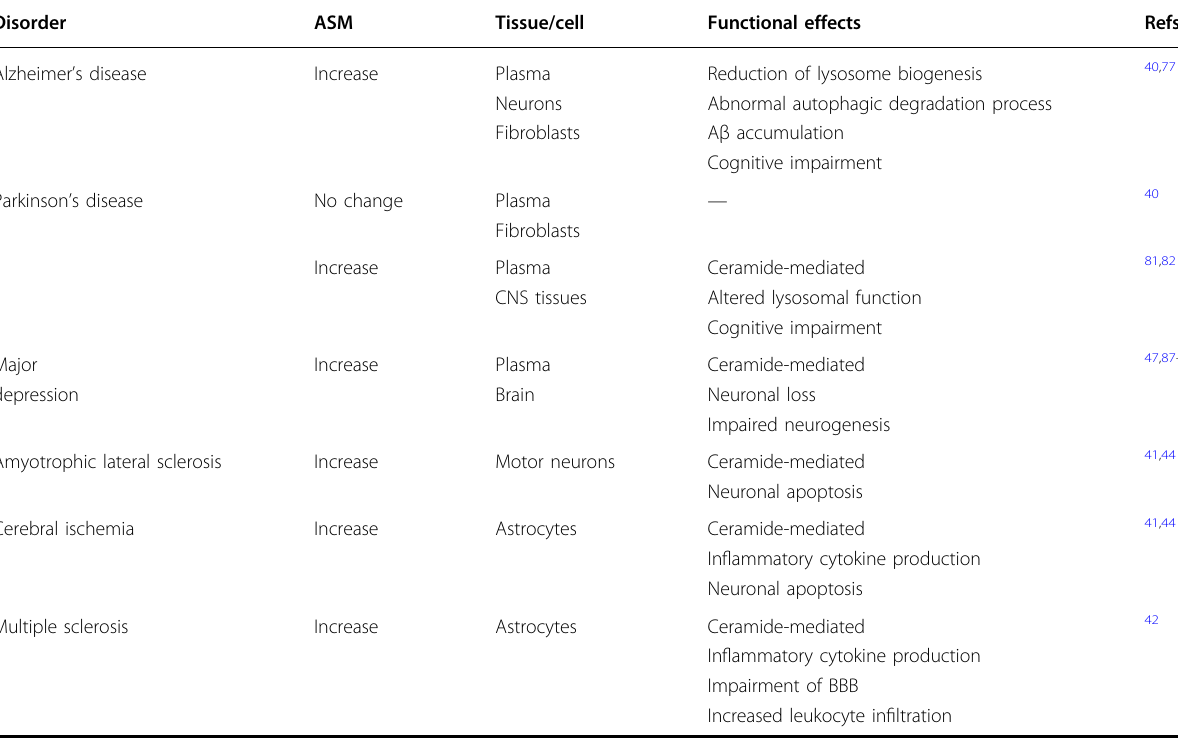
Table 1 ASM-mediated pathologies in age-related neurodegenerative disorders.